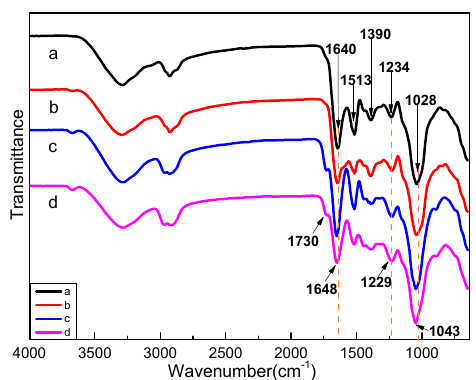
Figure 1. Fourier transform infrared (FTIR) spectra of the different adhesives: ( a ) SF adhesive; ( b ) SF/LB adhesive; ( c ) SF/PAE adhesive; and ( d ) SF/LB/PAE adhesive.